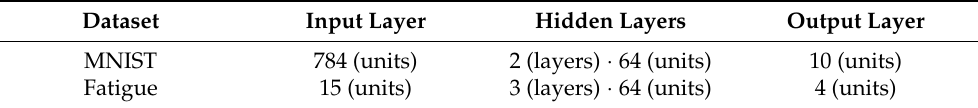
Table 3. The network structure of